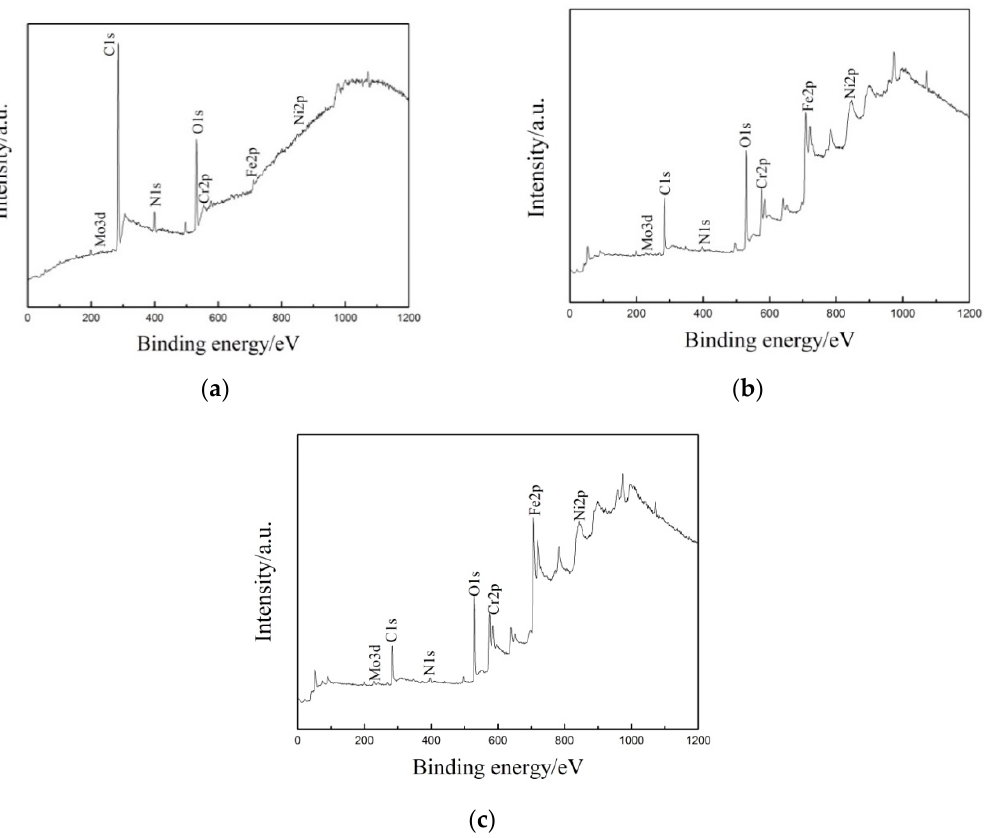
Figure 8. XPS full spectrum of the S3 sample after solution annealing with different sputtering depths ( a ) 0 nm; ( b ) 1 nm; ( c ) 2 nm.